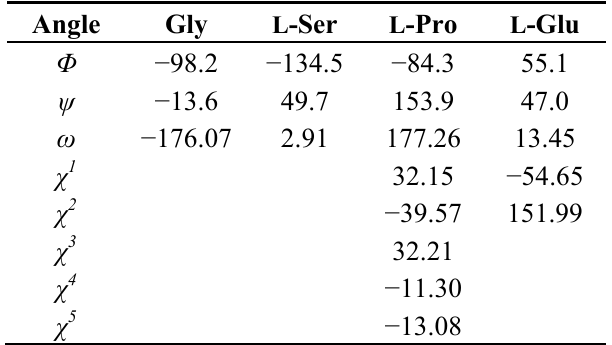
Table 2. Backbone and side-chain torsion angles (°) of 1